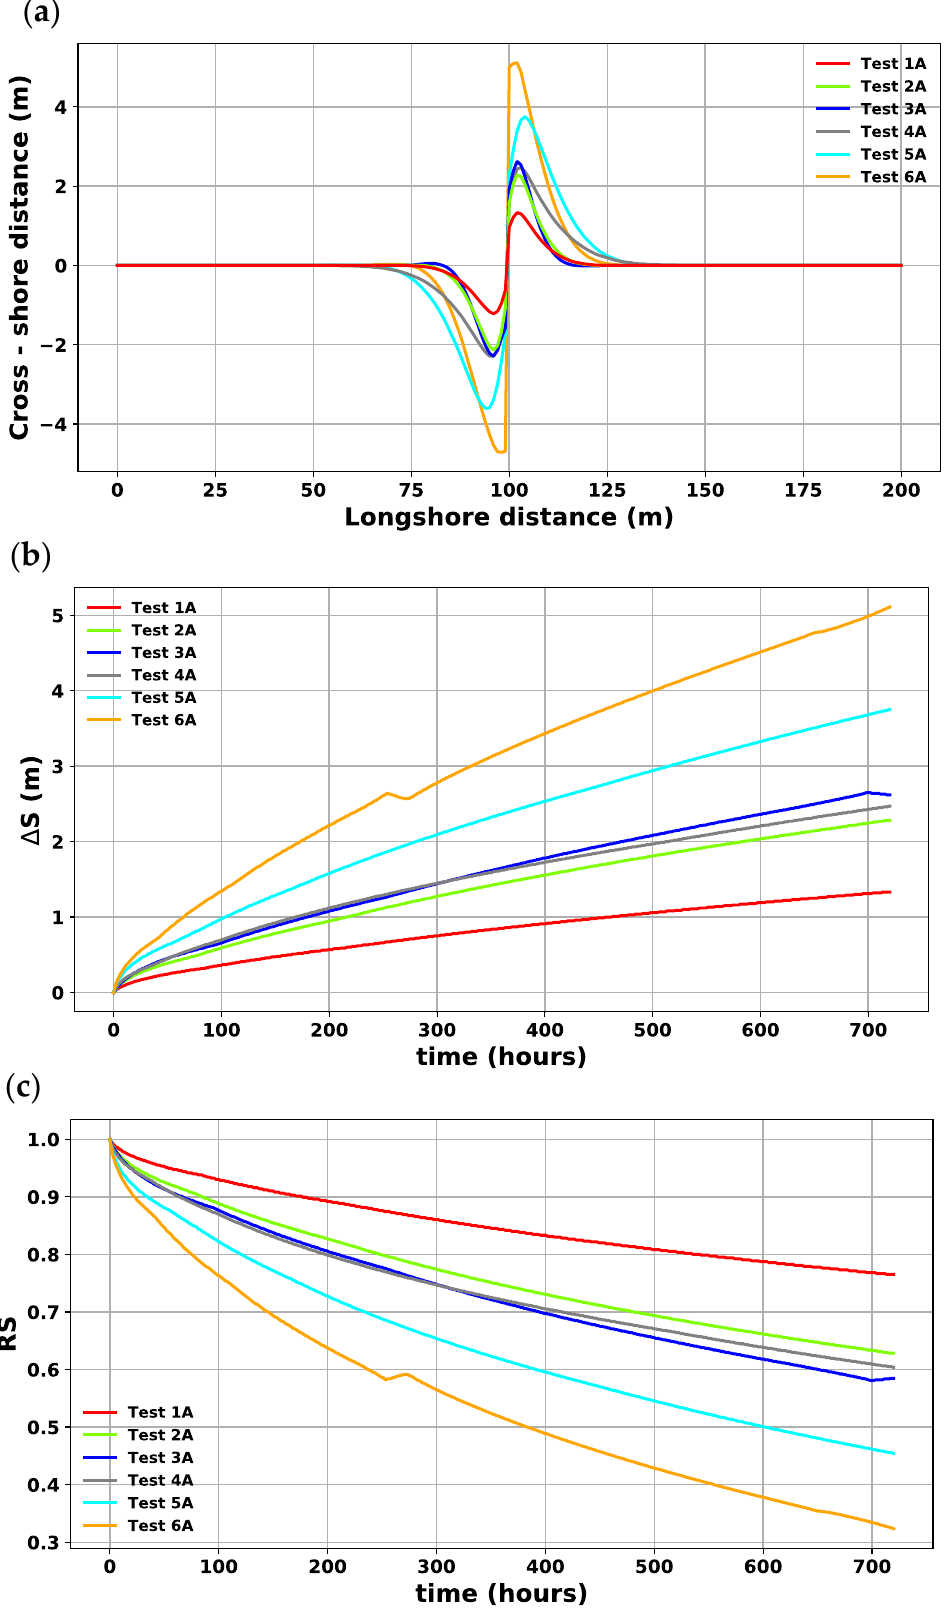
Figure 14. ( a ) Shoreline position, owing to the 10 m long groin presence, after 720 h ( b ) the corresponding shoreline distance increases for different wave conditions listed in Table 4 and ( c ) resistance index temporal evolution for different wave conditions listed in Table 4.